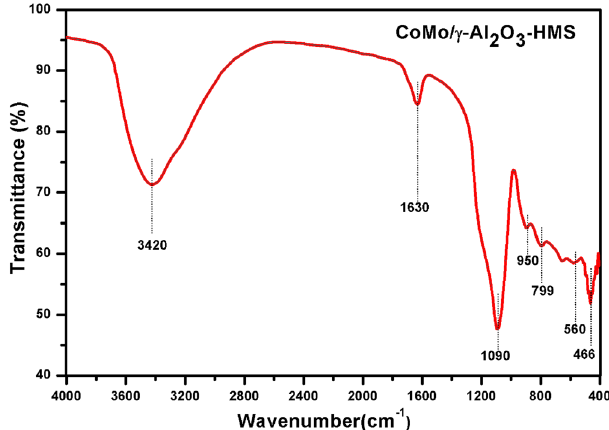
Figure 4. IR spectrum of CoMo/γ-Al 2 O 3 -HMS catalyst.